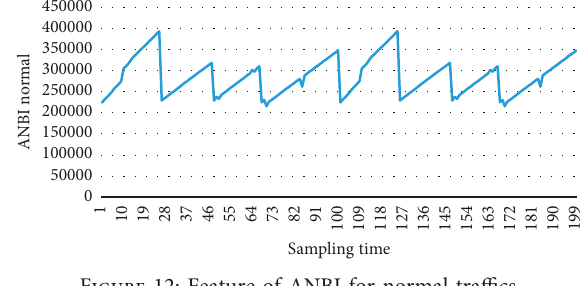
Figure 12: Feature of ANBI for normal traffics.